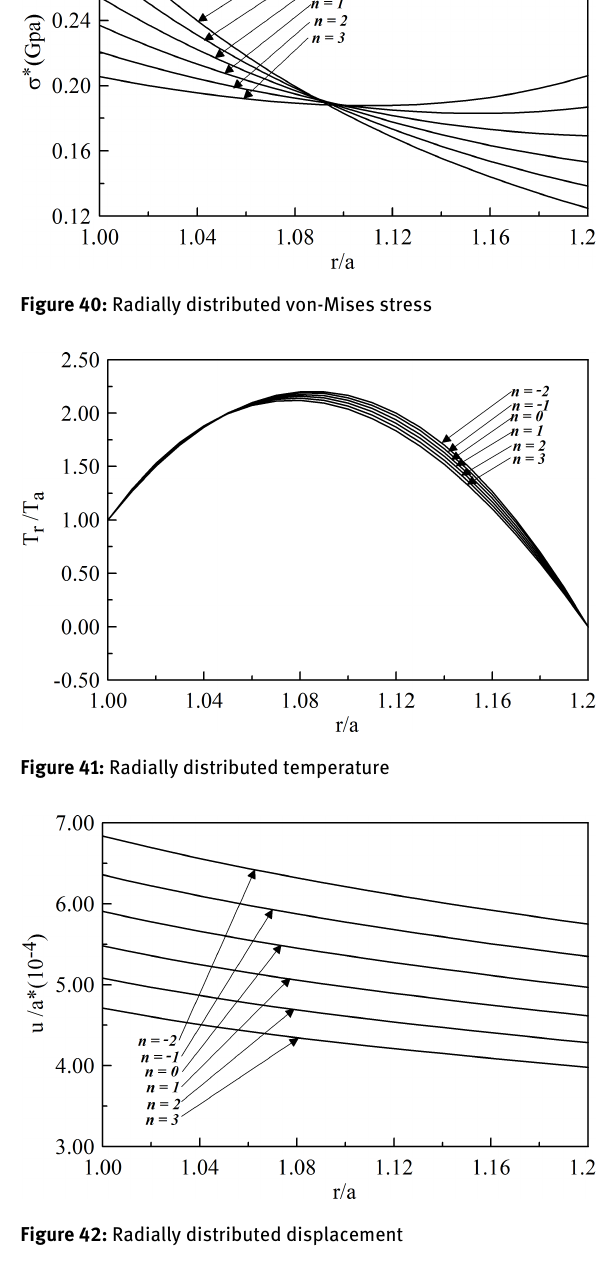
Figure 41 and displacement and stresses are shown in fig- ures Figure 42 to 45.